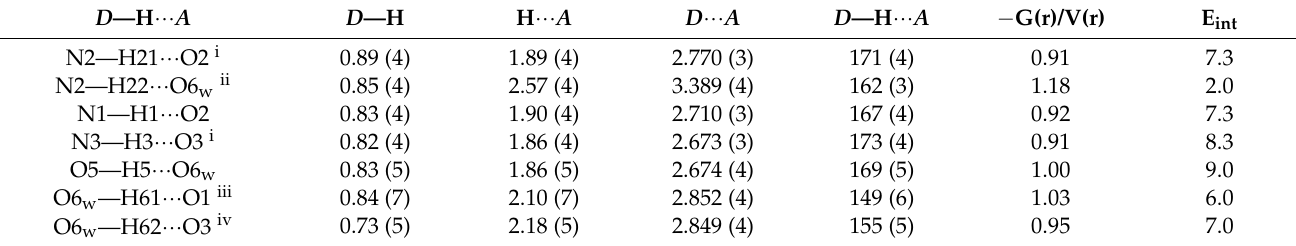
Table 6. Hydrogen-bond geometry (Å, ◦ ) and topological analysis for compound ( VI ). E int is reported in kcal/mol. For additional details concerning QTAIMS results see Tables S13 and S14 in the Supporting